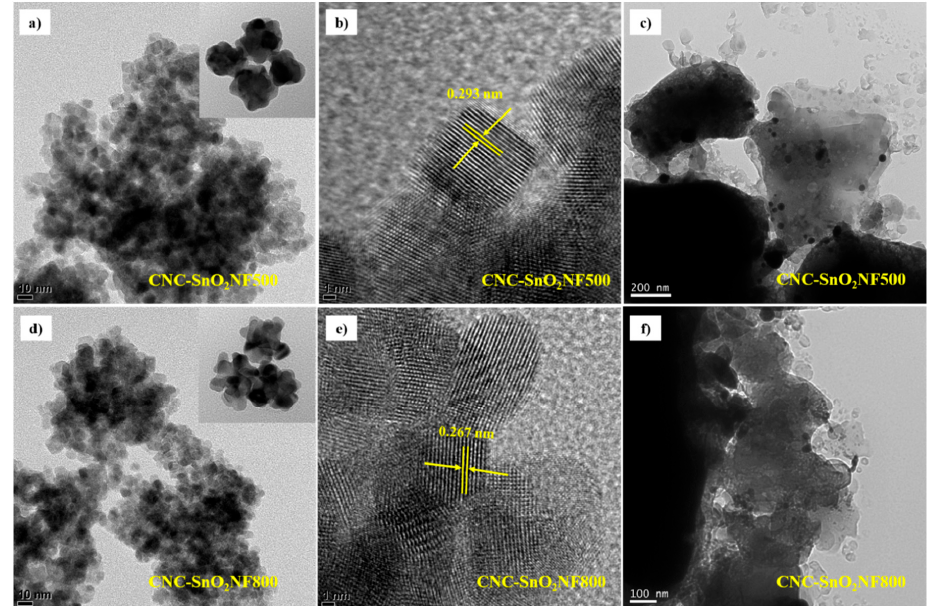
Figure 3. ( a , d ) Typical TEM, ( b , e ) HRTEM, ( c , f ) and low-magnification TEM images of